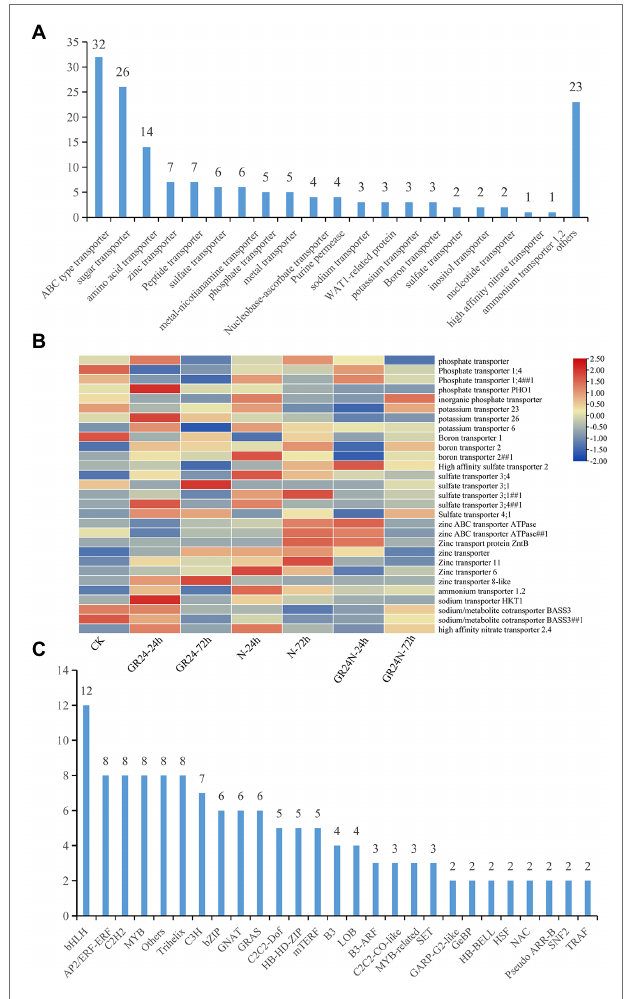
FIGURE 4 | Screening of differentially expressed genes related to transcription factors and substance transporters. (A) Identification of differential genes associated with transporters. (B) The heat map shows the expression levels of nutrient-related transporters in each treatment. (C) Identification of differentially expressed genes that are transcription factors. A total of 26 families of transcription factors were